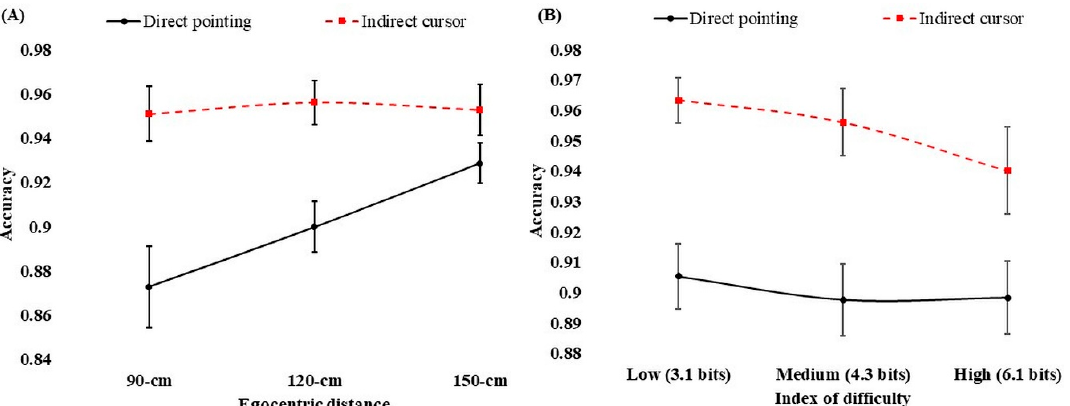
Figure 4. Results of accuracy measurement for direct pointing and indirect cursor interaction techniques with respect to egocentric distance ( A ) and index of difficulty ( B ). The error bar represents standard error of mean.